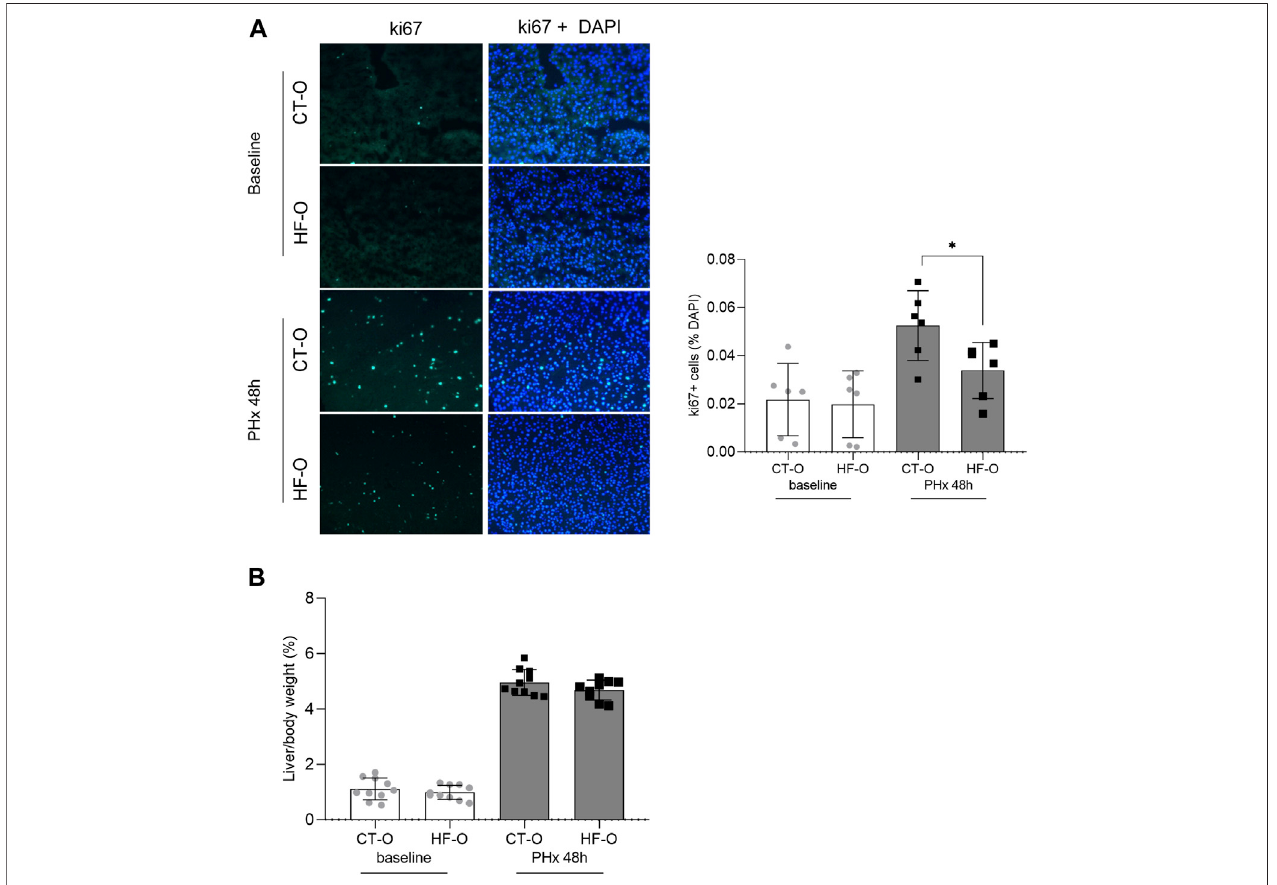
FIGURE 4 | Liver regeneration capacity from the offspring of control and obese dams 48 h after partial hepatectomy. Immuno fl uorescence of hepatic ki67 content (A) and liver/body weight ratio (B) from the offspring of control (CT-O) and obese (HF-O) dams, 48 h (PHx 48 h) after partial hepatectomy surgery. Data are plotted as individual values (dot plots), means and SEM, represented by vertical bars. n = 6 – 10/group. * p ≤ 0.05 and ** p ≤ 0.005 after Student ’ s t -test (CT-O versus HF-O).